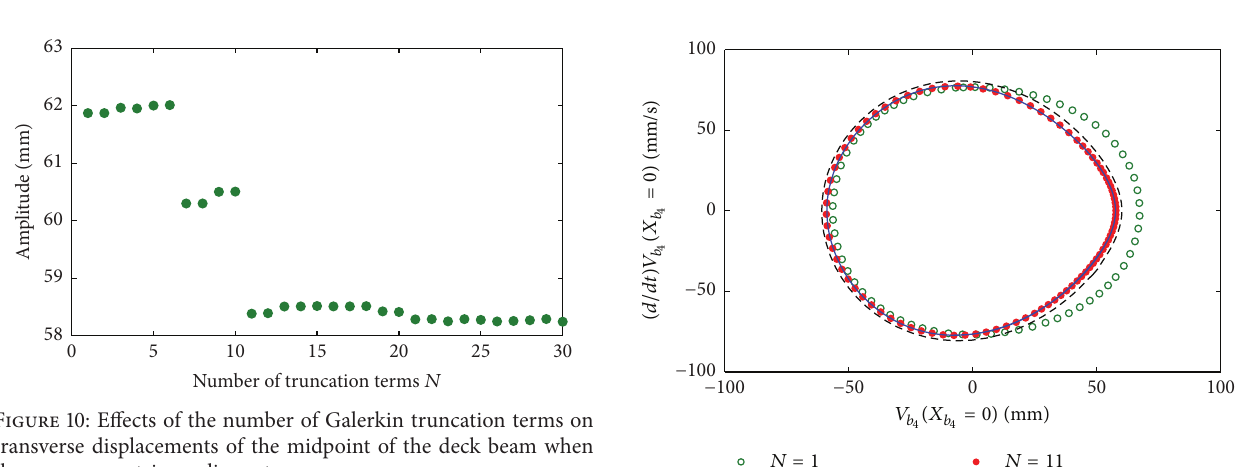
when 𝑞 1 (0) is larger than or equal to 0.27, chaotic